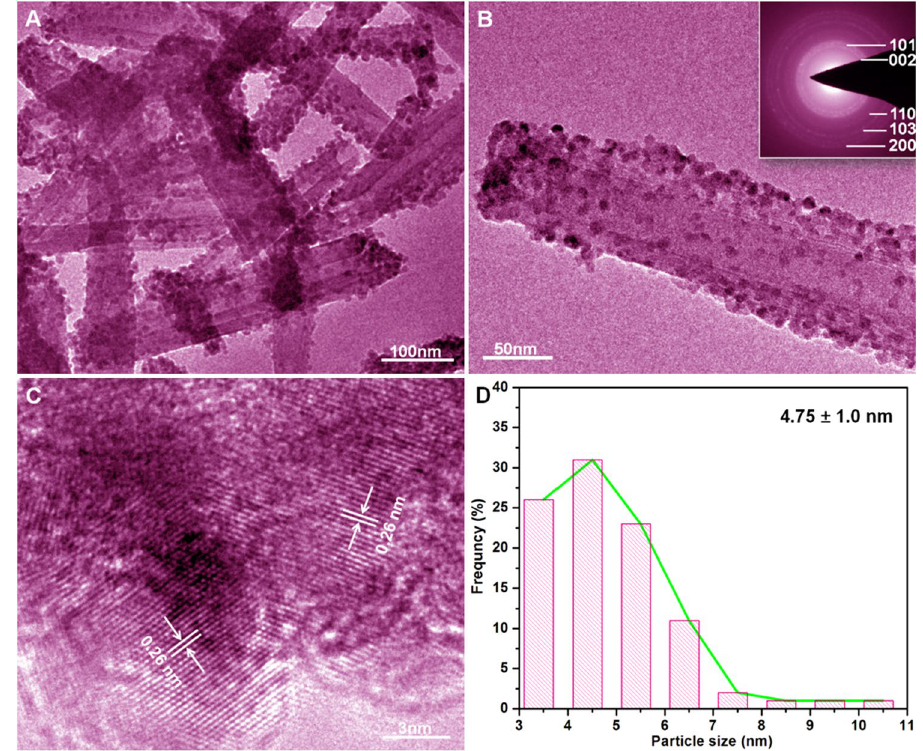
Figure 4. ( A , B ) TEM and ( C ) HRTEM images of HNTs@ZnO, ( D ) ZnO particle-size